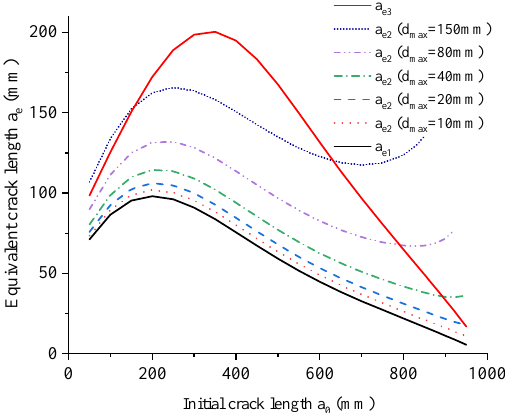
Figure 3. Equivalent crack length a e versus initial crack length a 0 for different maximum aggregate size d max when β 1 = 1.